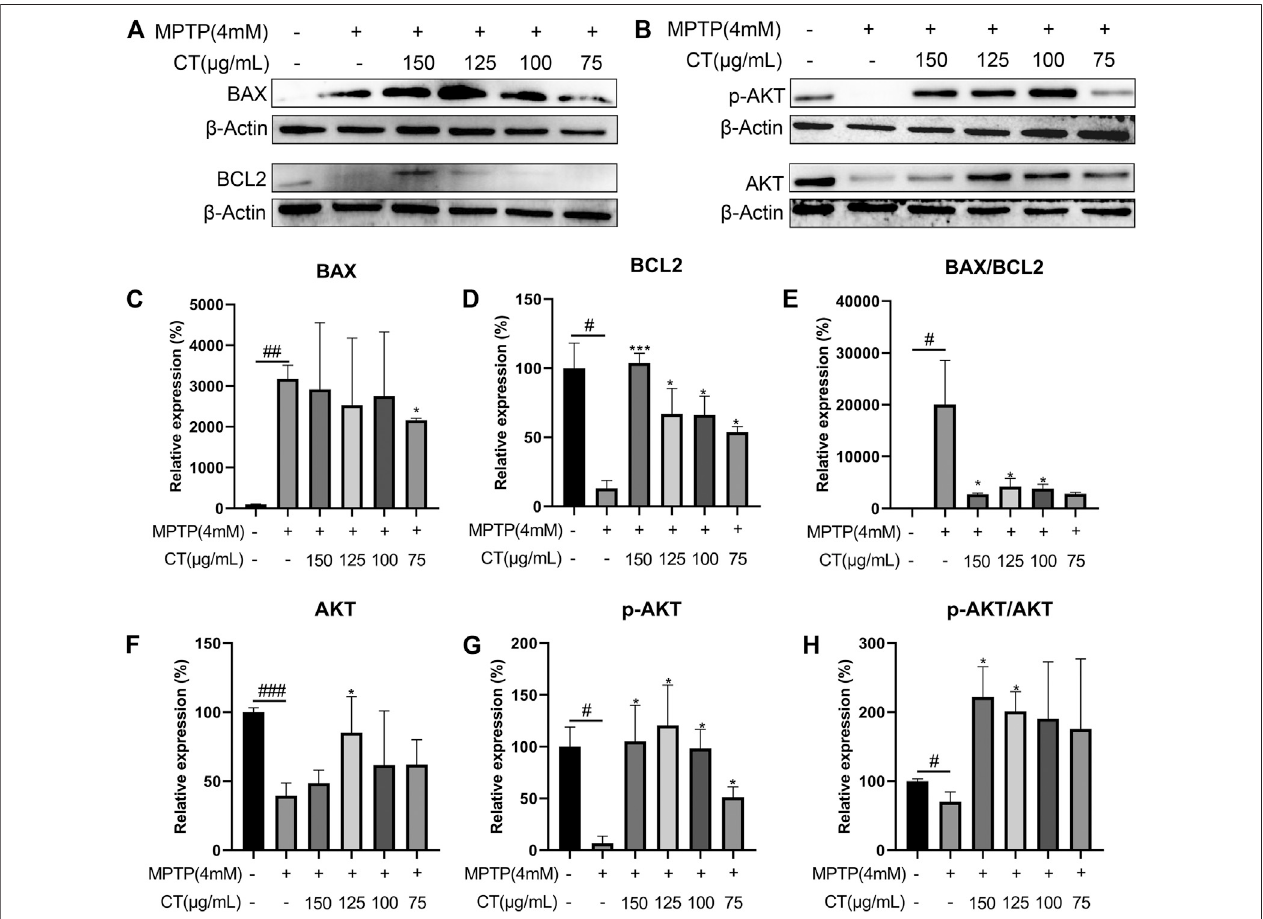
FIGURE 8| Protein expression levels ofBAX, BCL2 (A,C – E) , pAKT, and AKT (B,F – H) in cells treated withthe CT extract. Data were shown asmean ± SD ( n = 3). # p < 0.05, ## p < 0.01, ### p < 0.001 when compared with the control group. * p < 0.05, *** p < 0.001 when compared with the MPTP-induced model group.